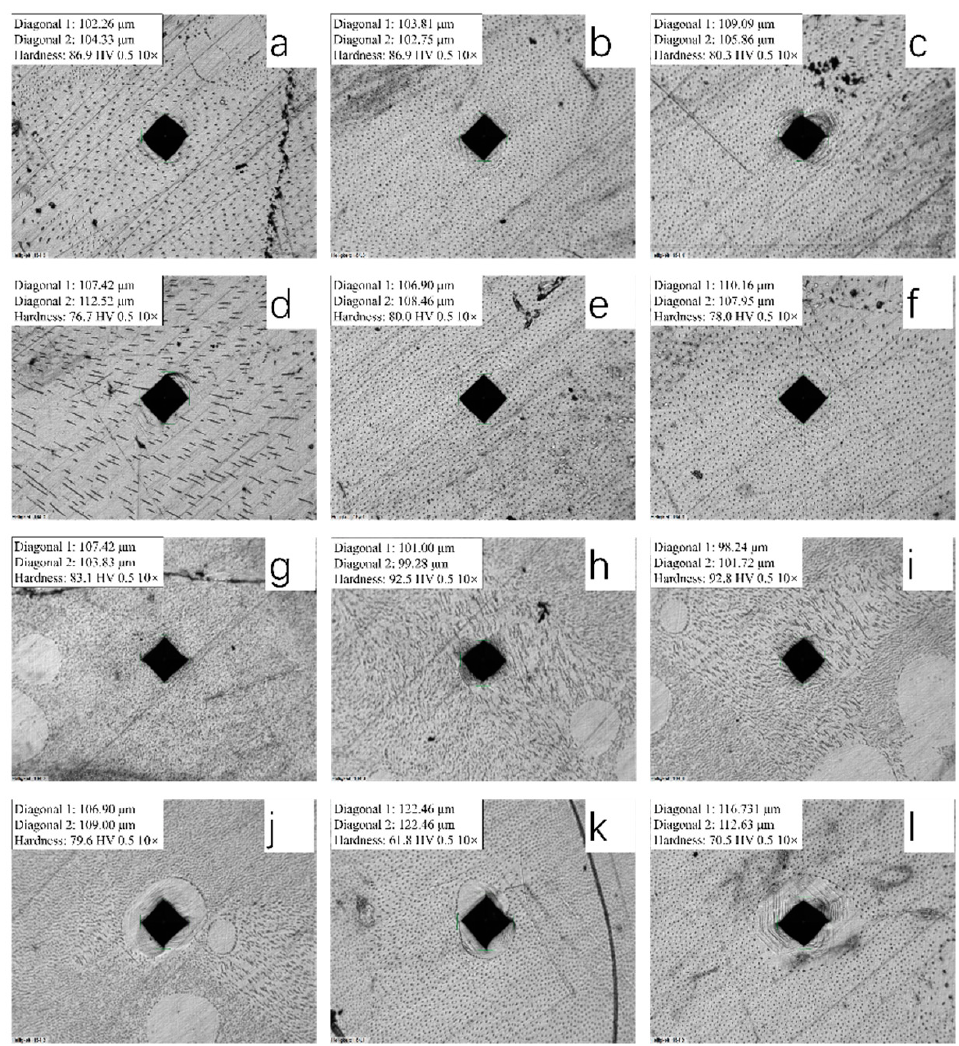
Figure 7. Sample microhardness (overall hardness values, a : 86.9 HV, b : 86.9 HV, c : 78 HV, d : 76.7 HV, e : 80 HV, f : 78 HV; eutectic areas, g : 83.1 HV, h : 92.5 HV, i : 92.8 HV; precipitation-free areas, j : 79.6 HV, k : 61.8 HV, l : 70.5 HV).